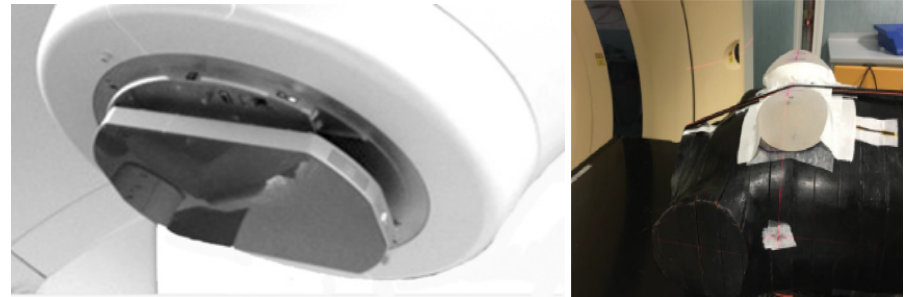
Figure 2. Left . The Integral Quality Monitor detector (IQM) system mounted on the linac head. Right . Alderson RANDO phantom with two silicon prostheses to simulate the female